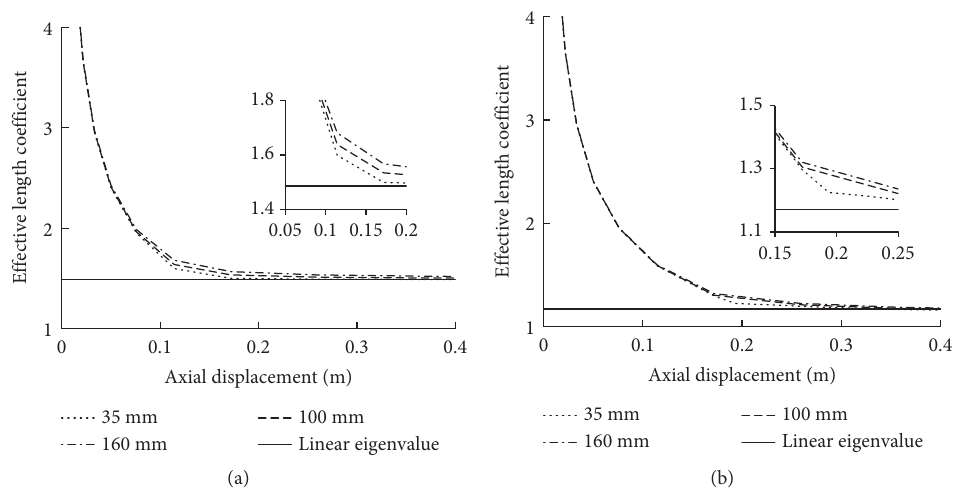
Figure 15: Effective length coefficient of the lateral displacement imperfection. (a) Case 1. (b) Case